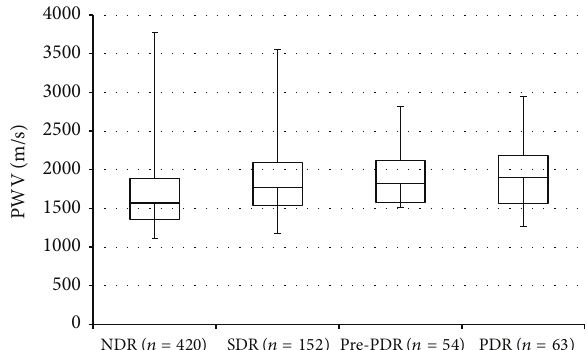
Figure 1: Pulse wave velocity (PWV) in NDR ( 𝑛 = 420 ), SDR ( 𝑛 = 152 ), pre-PDR ( 𝑛 = 54 ), and PDR ( 𝑛 = 63 ). Significant difference among groups ( 𝑃 < 0.001 ) was detected by the Kruskal- Wallis test. NDR: no diabetic retinopathy, SDR: simple diabetic retinopathy, pre-PDR: pre-proliferative diabetic retinopathy, and PDR: proliferative diabetic